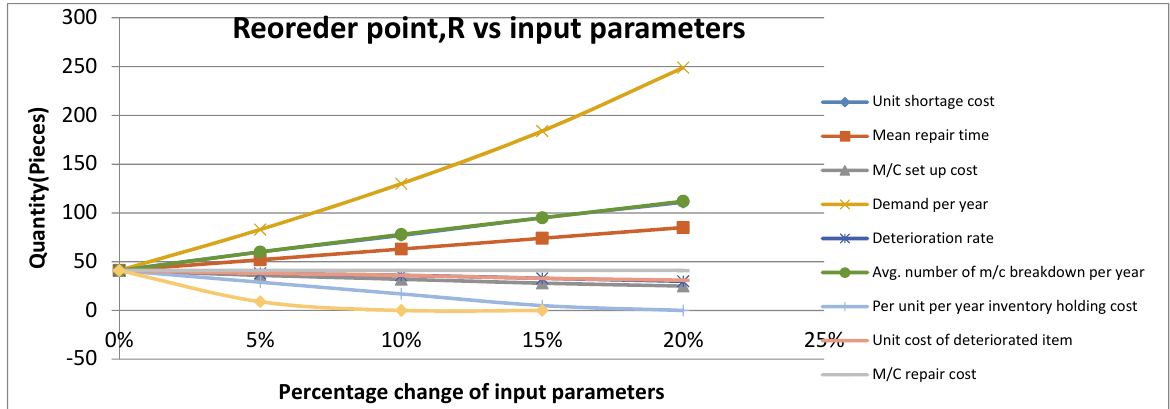
Fig. 15. Sensitivity analyses for production reorder